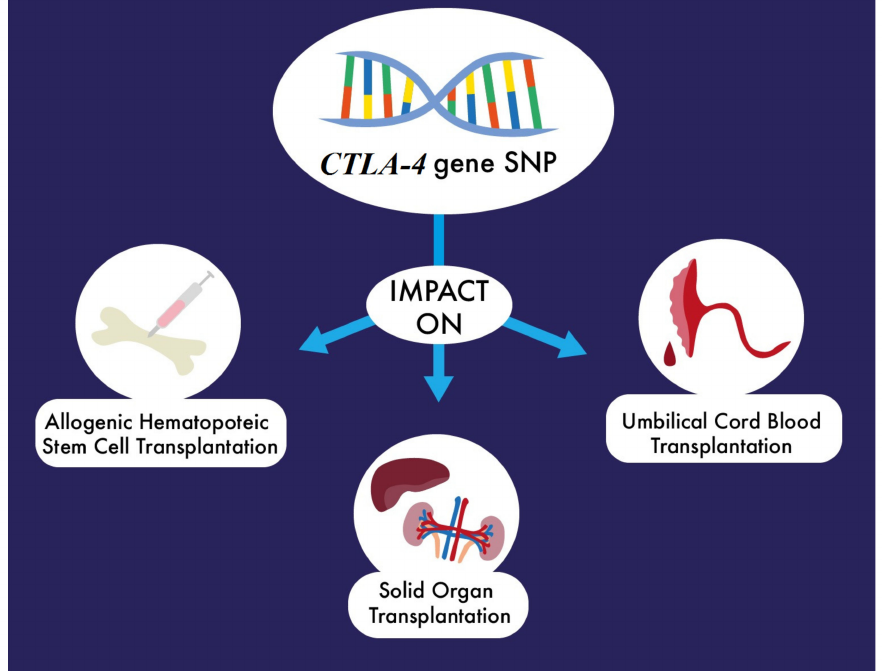
Figure 2. CTLA4 is an important immunomodulatory protein and its genetic variations are involved in the pathogenesis of various diseases. CTLA4 gene SNPs are suspected to influence outcomes of dif- ferent types of transplantation, such as allogeneic haematopoietic stem cell transplantation, umbilical cord blood transplantation, and solid organ transplantations (kidney and liver